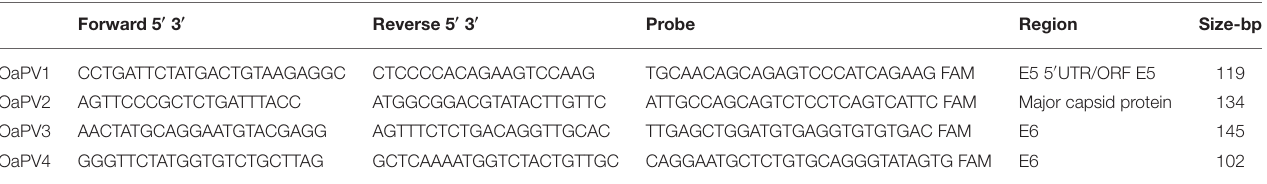
TABLE 1 | Primers and probes used for the detection of OaPVs in ddPCR and qPCR. Forward 5 ′ 3 ′